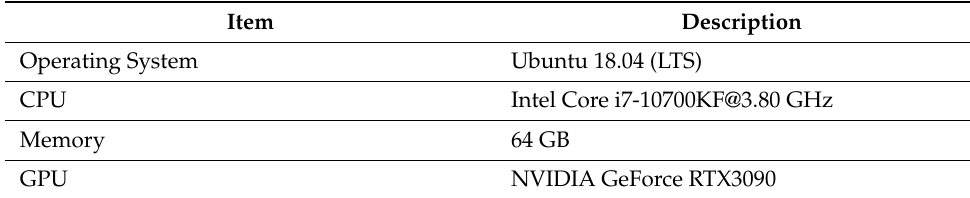
Figure 1. UAV with RGBD stereo camera [33]. Table 1. Speci fi cations of the workstation used to train di ff erent detector models.